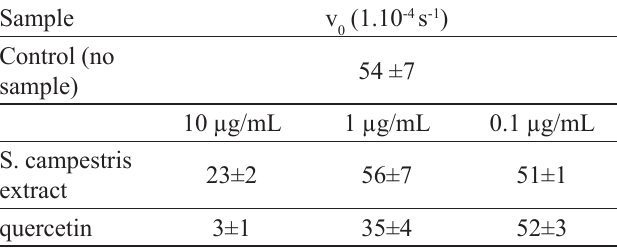
O (0.2 mM) and guaiacol 2 2